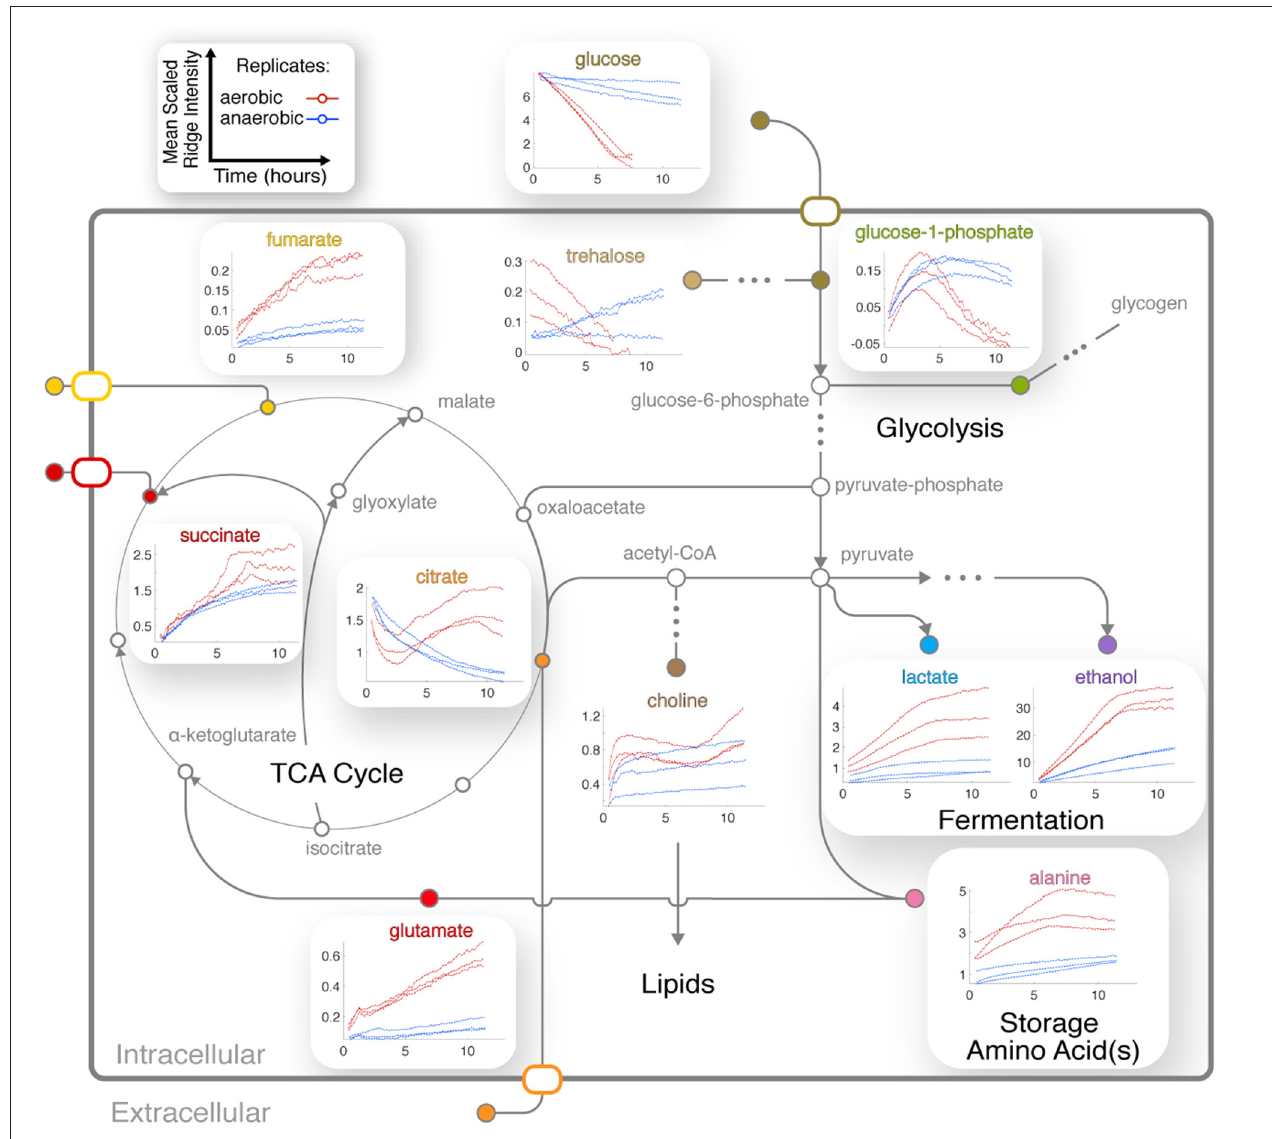
FIGURE 5 | Integration of central metabolic pathways. Arrows correspond to one or more reactions, and nodes correspond to metabolites (Dreyfuss et al., 2013; Kanehisa et al., 2016). Nodes are filled for observed metabolites. Plots show the means of scaled peak/ridge intensities for a given compound in a given replicate over traceable times, where red and blue trajectories represent aerobic and anaerobic conditions, respectively. Arrows indicate typical reaction directions. The glyoxylate cycle is shown as a shunt through glyoxylate embedded in the TCA cycle.